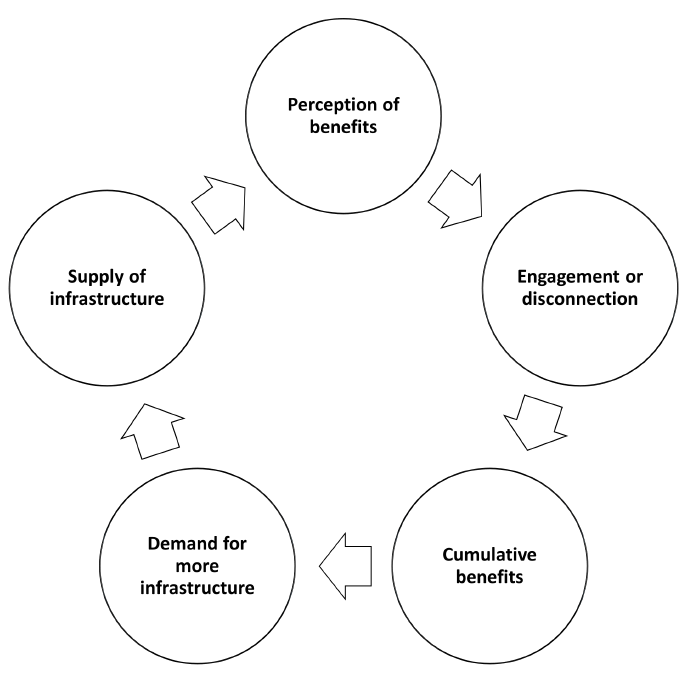
Figure 2: An engagement cycle in the digital